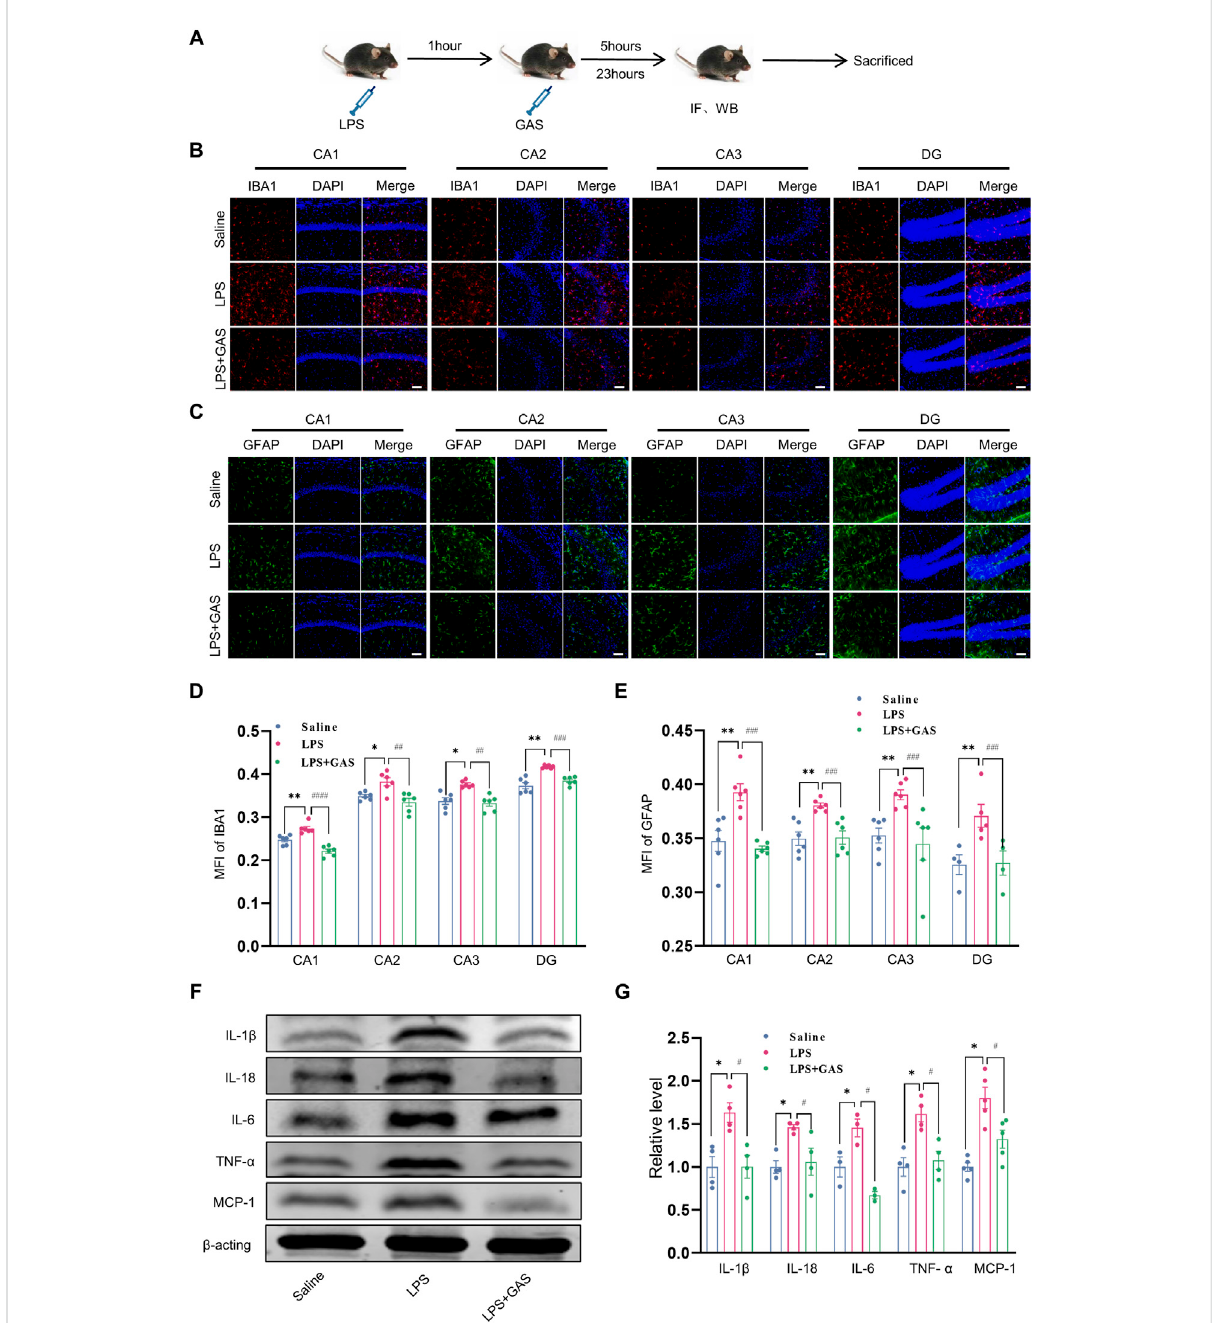
FIGURE 2 Effects of GAS on neuroin fl ammation in the hippocampi of mice. (A) This part of the experimental fl ow chart. (B – E) representative images of IF staining and histograms of MFI for GFAP-positive astrocyte (green), and IBA1-positive microglia (red) in the CA1, CA2, CA3, and DG regions of hippocampus. Scale bar = 30 μ m. (F,G) Representative protein bands and the histograms of bands intensity analysis of IL-1 β , IL-18, IL-6, TNF- α , and MCP-1 in the hippocampus. Values are represented as means ± SEM for three mice in each group. *** p < 0.001, ** p < 0.01, * p < 0.05 versus saline group; ### p < 0.001, ## p < 0.01, # p < 0.05 versus LPS group. LPS, lipopolysaccharide; GAS, gastrodin; IL-1 β , Interleukin-1; IL-6, Interleukin-6; IL-18, Interleukin-18; TNF- α , Tumor necrosis factor- α ; MCP-1, Monocyte Chemoattractant Protein-1; IF, Immuno fl uorescence; WB, western blot; MFI, the mean fl uorescence